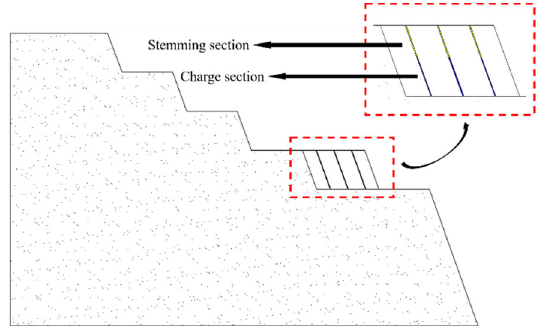
Figure 1. Geometric diagram of the numerical model.